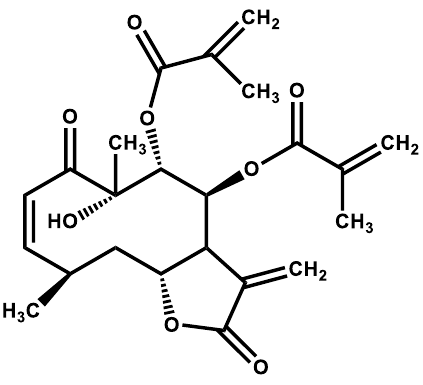
Figure 1. The structure of juanislamin.